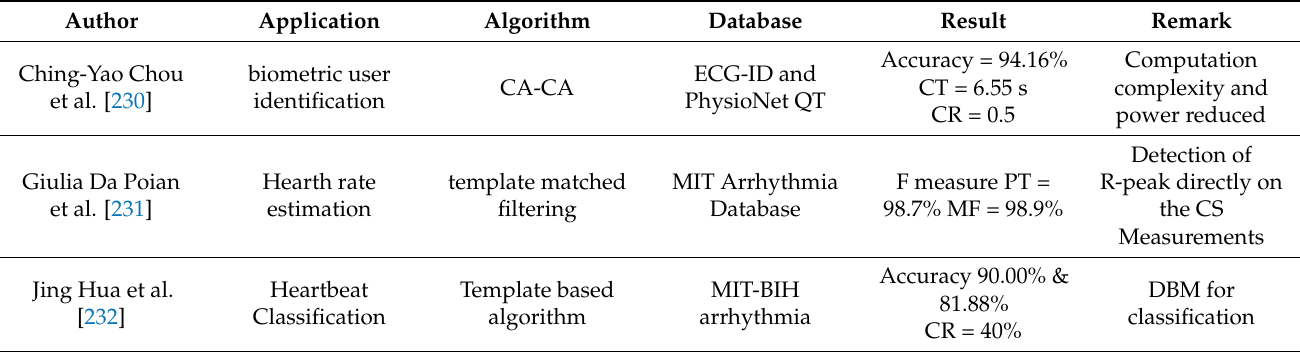
Table 4. CS Models without the Reconstruction